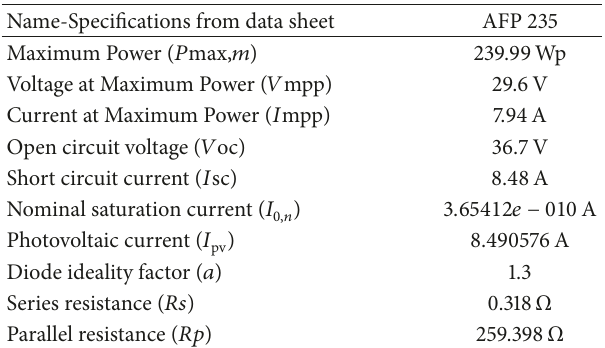
Table 2: Adjusted parameters of the Altius AFP 235 at nominal operating conditions.